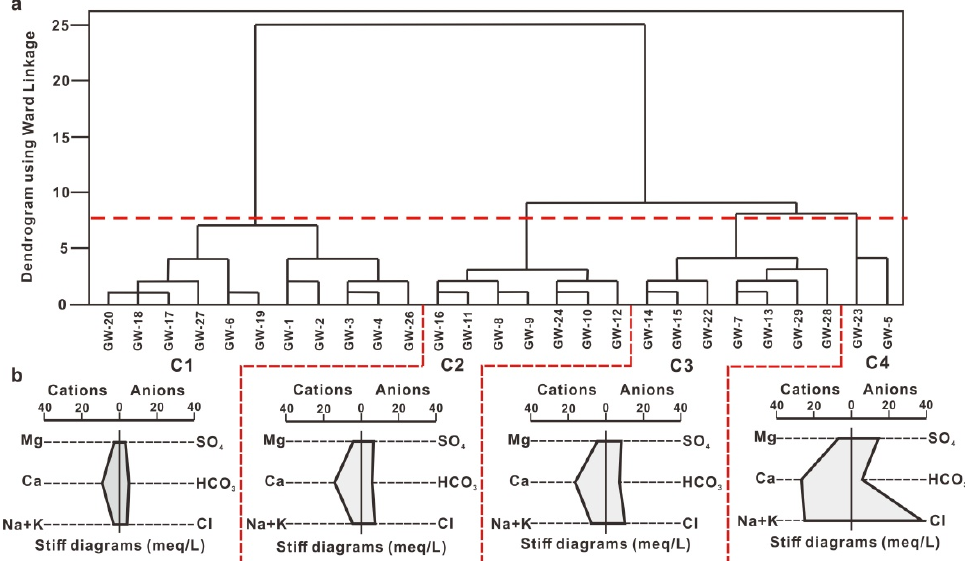
Figure 2. Dendrogram of the Q-mode hierarchical cluster analysis ( a ) and Stiff diagram showing the average ion compositions of each cluster ( b ). The spatial distribution of groundwater samples of different cluster types is centered within the area defined by C3 samples, as shown in Figure 1. C3